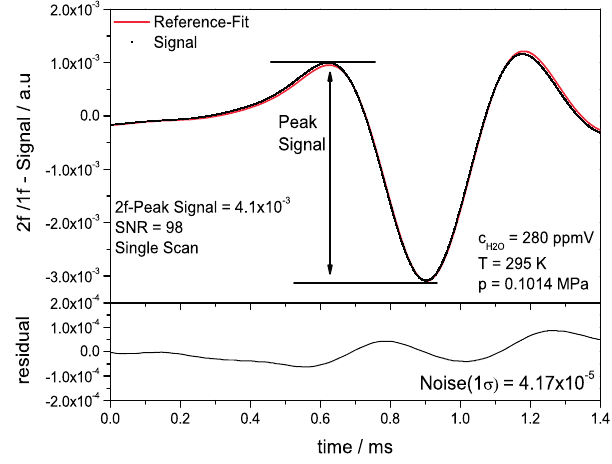
Figure 12. Single WMS 2f/1f scan measured at 280 ppmV H 2 O using a 125 Hz triangle modulation with a 20 kHz superimposed sinusoidal. A correlation fit to a WMS reference scan at 750 ppmV is